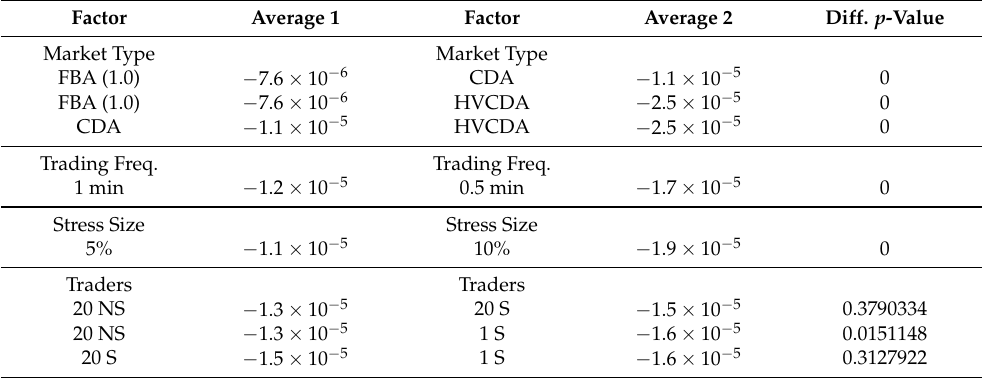
Table 8. Tukey’s HSD test applied to the resulting non-interaction terms of the analysis of variance in Table 7. Factor Factor Diff. p -Value Market